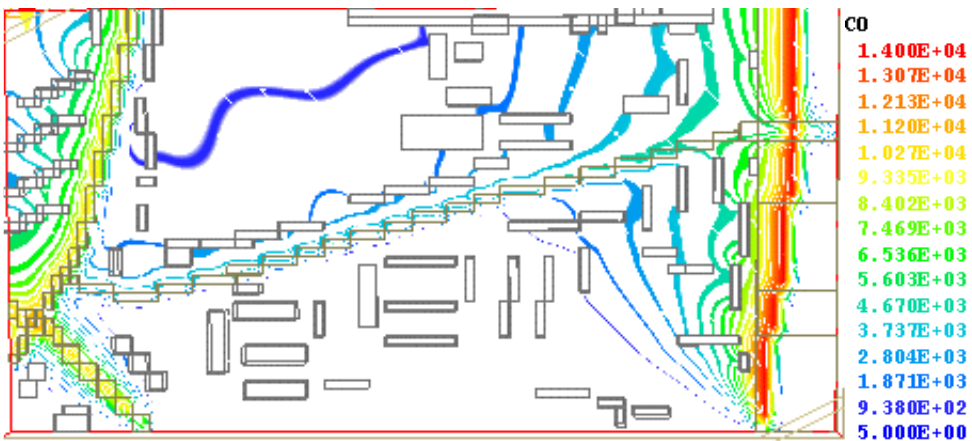
3 1,5 m nuo žemės paviršiaus, maksimali 3 ) 1,5 m from surface of earth, 3 3 , DLK – 5,0 µ g/m